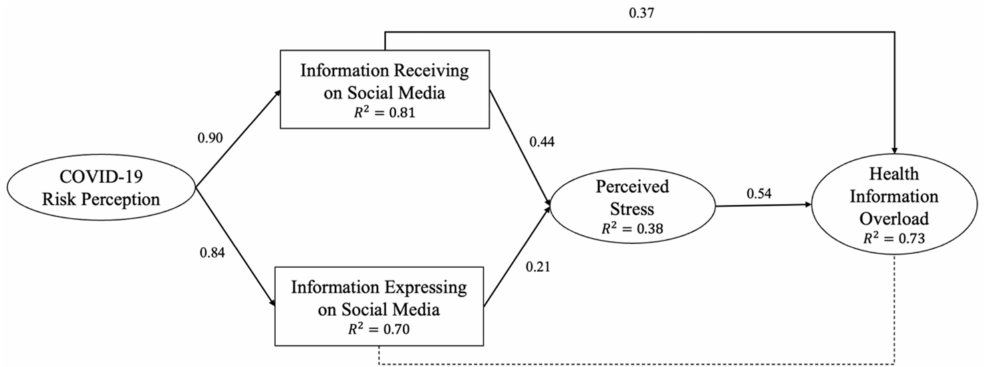
Figure 2. Conceptual model after